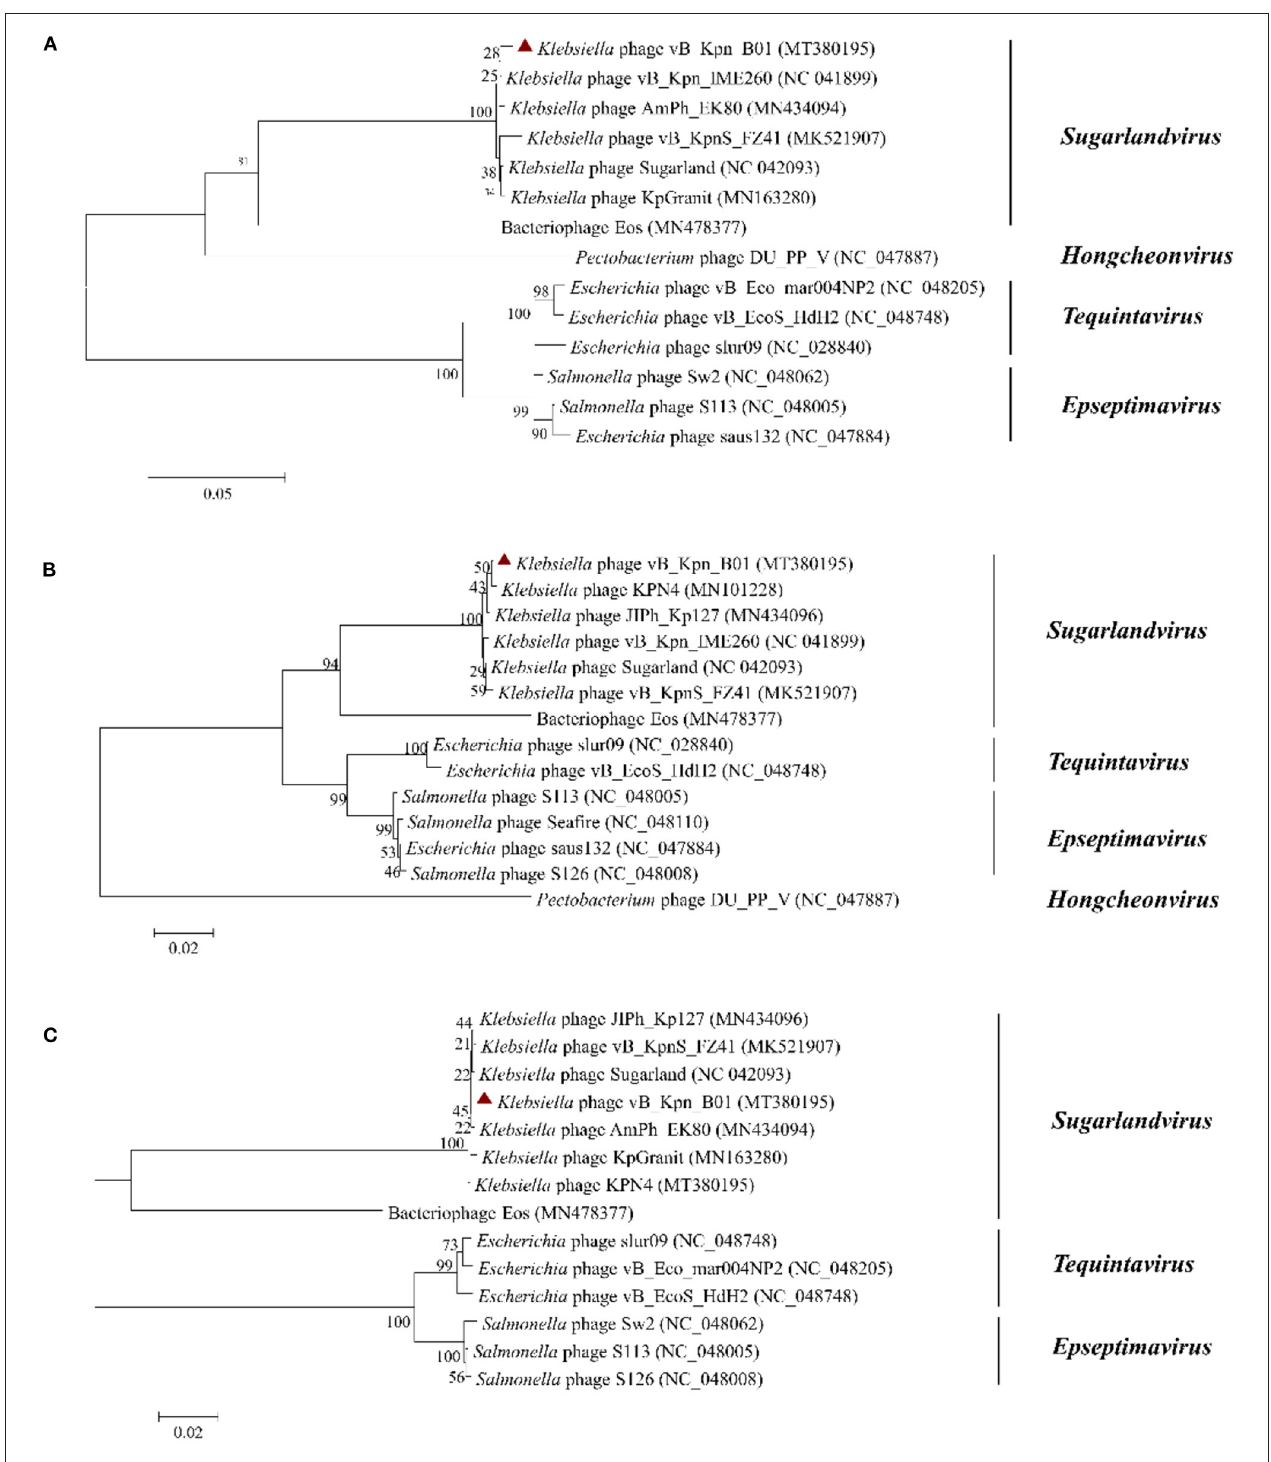
FIGURE 5 | Phylogenetics trees were constructed based on major capsid protein (A) , terminase large subunit (B) , and DNA polymerase (C) of the phage. The number on the branch point represents credibility (the closer the value is to 100, the stronger the credibility). The length of the branches represents the genetic distance; the shorter the ruler, the closer the relationship. Red triangle: phage vB_Kpn_B01.